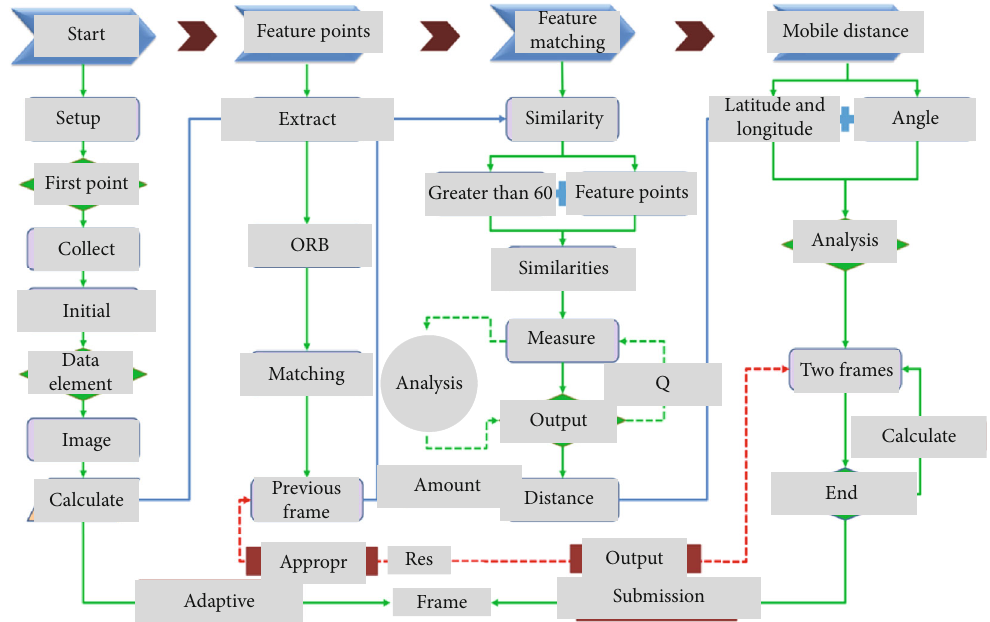
Figure 2: Image matching fl ow based on feature